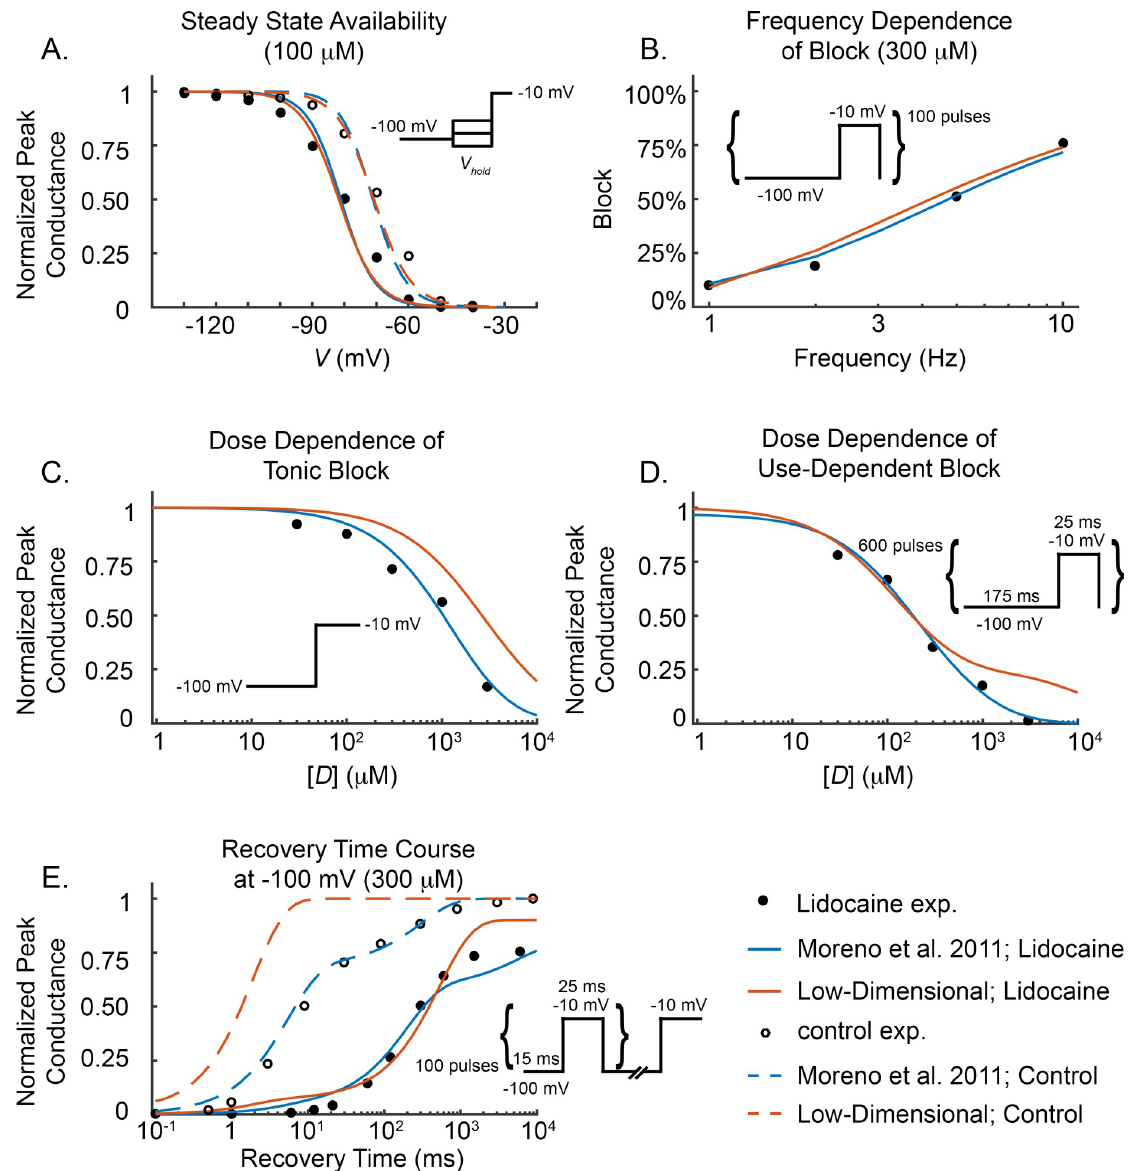
Fig 3. Lidocaine voltage-clamp data. Experimental voltage-clamp data (filled circles), Moreno et al. 2011 model fit (solid blue curves), low- dimensional model output (solid orange curves) for lidocaine effects on the Na + conductance. V -clamp data for control, i.e. no drug, experiments (open circles), Moreno et al. (blue dashed curves), and low-dimensional model with no drug (orange dashed curves) are included for appropriate protocols. (A) Steady state availability with SSE of 3.6 × 10 − 3 and 2.9 × 10 − 3 for the Moreno et al. and low- dimensional lidocaine models, respectively. (B) Frequency dependence of block with SSE of 8.8 × 10 − 4 and 1.7 × 10 − 3 for the Moreno et al. and low-dimensional lidocaine models, respectively. (C) Tonic block with SSE of 3.1 × 10 − 3 and 0.033 for the Moreno et al. and low-dimensional lidocaine models, respectively. (D) Dose-dependence of use-dependent block with SSE of 1.3 × 10 − 3 and 1.1 × 10 − 2 for the Moreno et al. and low-dimensional lidocaine models, respectively. (E) Recovery from use-dependent block with SSE of 2.3 × 10 − 3 and 5.0 × 10 − 3 for the Moreno et al. and low-dimensional lidocaine models, respectively. SSE ¼ 1 output, and { x i } are the experimental data values